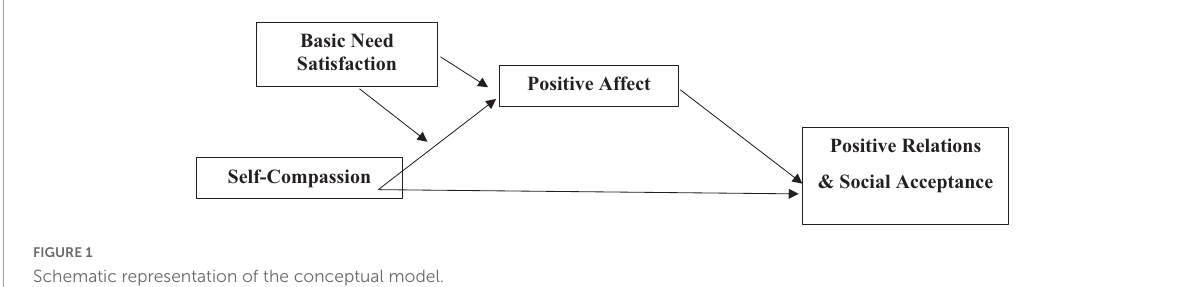
FIGURE1 Schematic representation of the conceptual model.